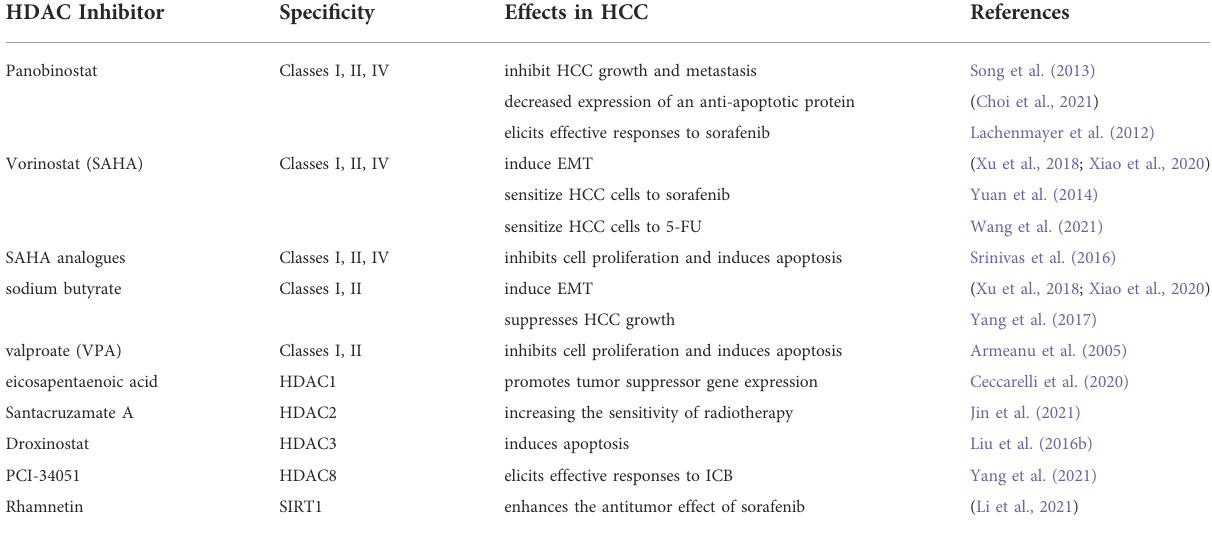
TABLE 3 Anti-cancer effects of HDAC inhibitors in